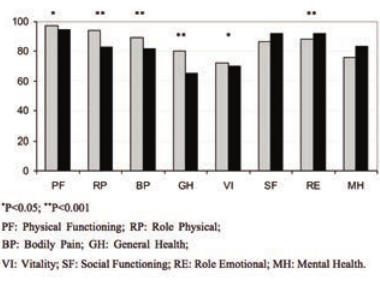
Figure 2. SF-36 scores before, during and after interferon- developed depression and in those who did